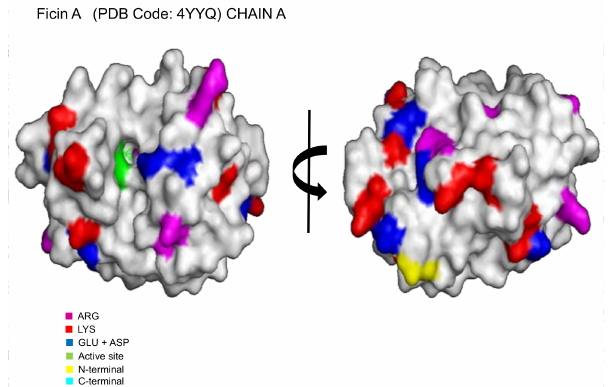
Figure 2. 3D surface structure model of Ficin A obtained from the Protein Data Bank (PDB) and displayed using PyMol versus 0.99. Arg, Lys, Glu+Asp, -NH 2 terminal and -COOH terminal residues are